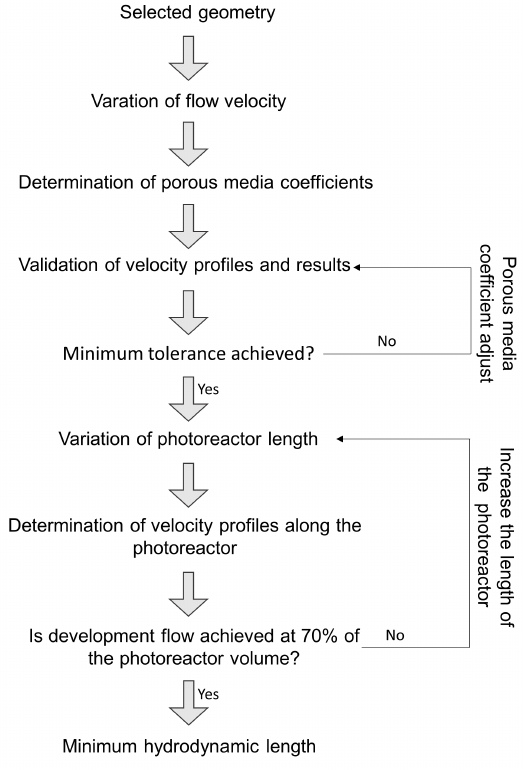
Figure 7. Methodology to calculate the minimum length of the